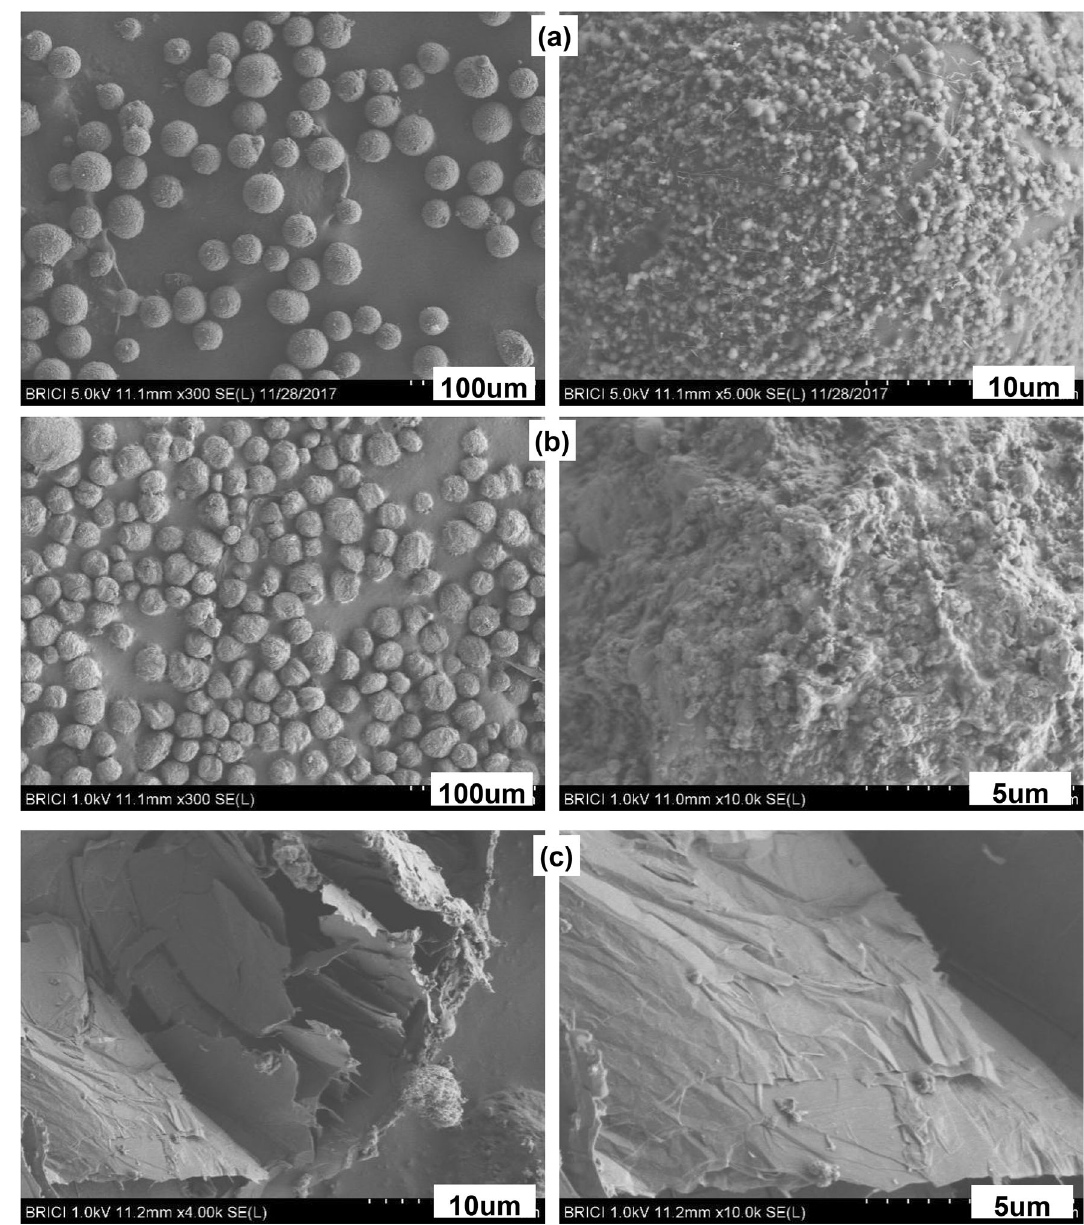
Fig. 8 SEM micrographs of MCMBs 10 and graphitized MCMBs 10 a MCMBs 10 . b , c graphitized MCMBs